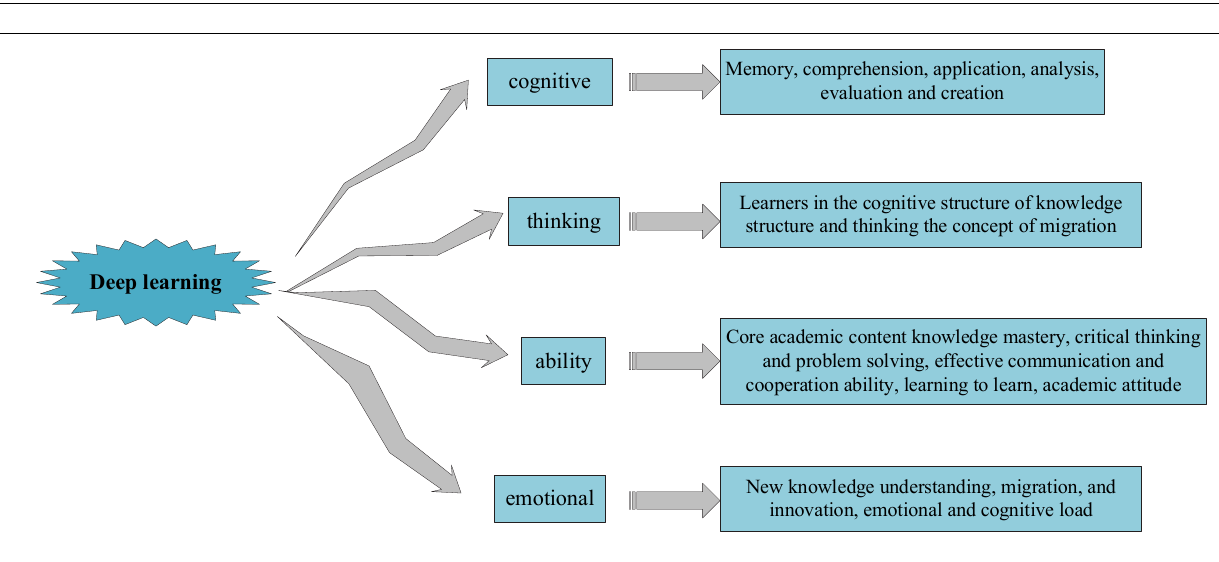
FIGURE 2 | Definition of deep learning (DL) from different